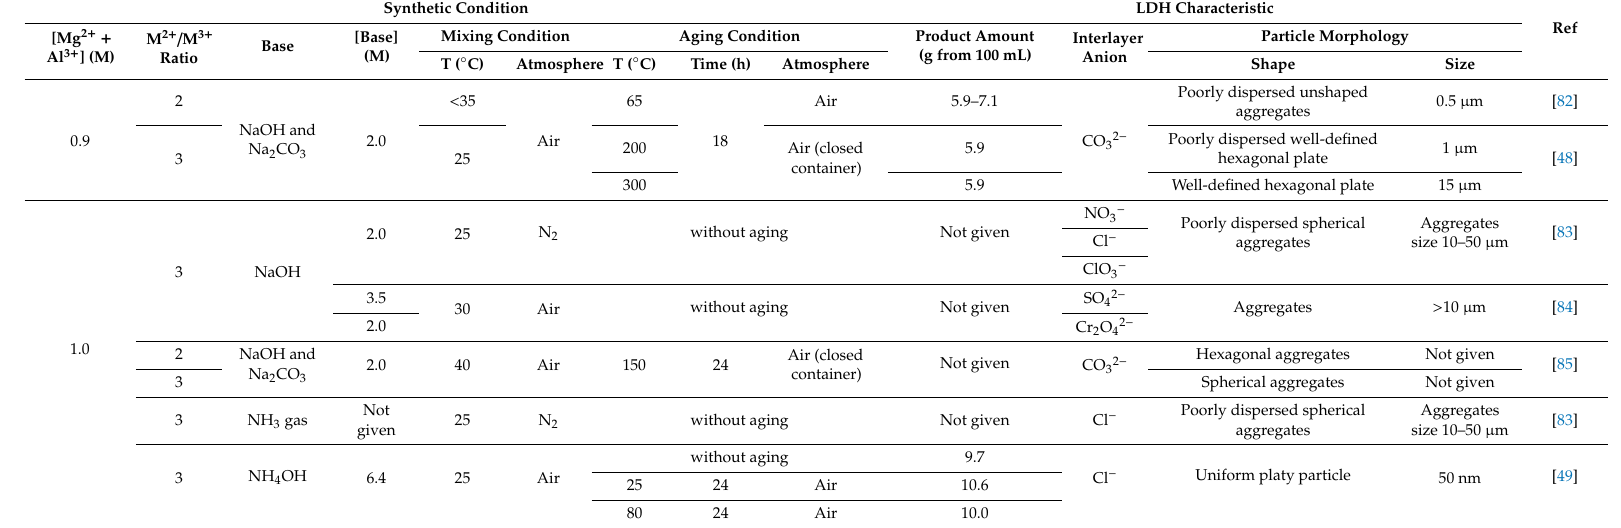
Table 1. Characteristics of the MgAl-LDHs obtained from concentrated solution of metal salts and the synthetic